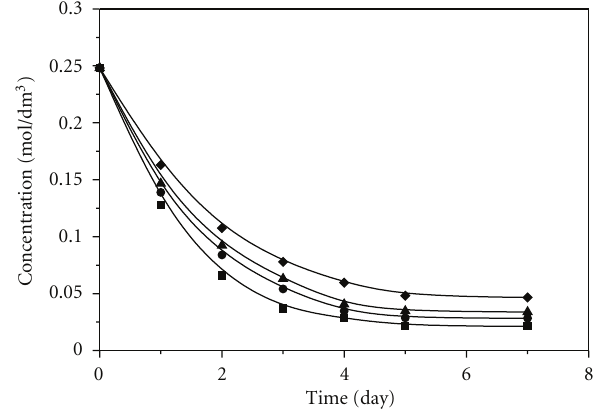
Figure 1: Change of allicin concentrations in acetonitrile, acetone, chloroform, and methanol at room temperature ( (cid:2) Acetonitrile; • Acetone; (cid:3) Methanol 55 ◦ C; (cid:4) Chloroform).